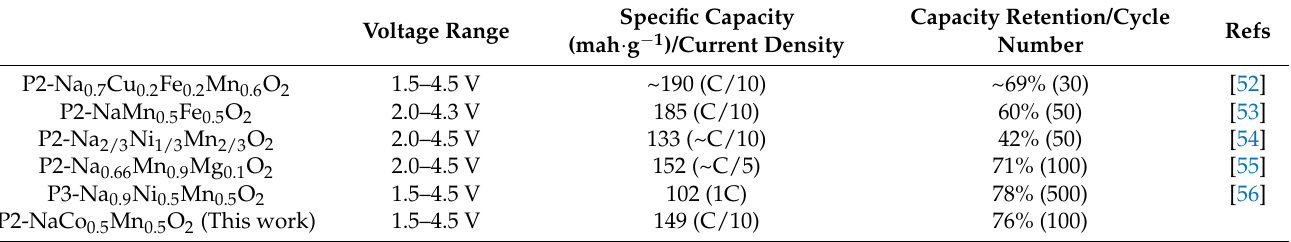
Table 3. Comparison of the electrochemical performance of electrode materials at high cutoff voltage. Specific Capacity Capacity Voltage Range (mah · g − 1 )/Current Density